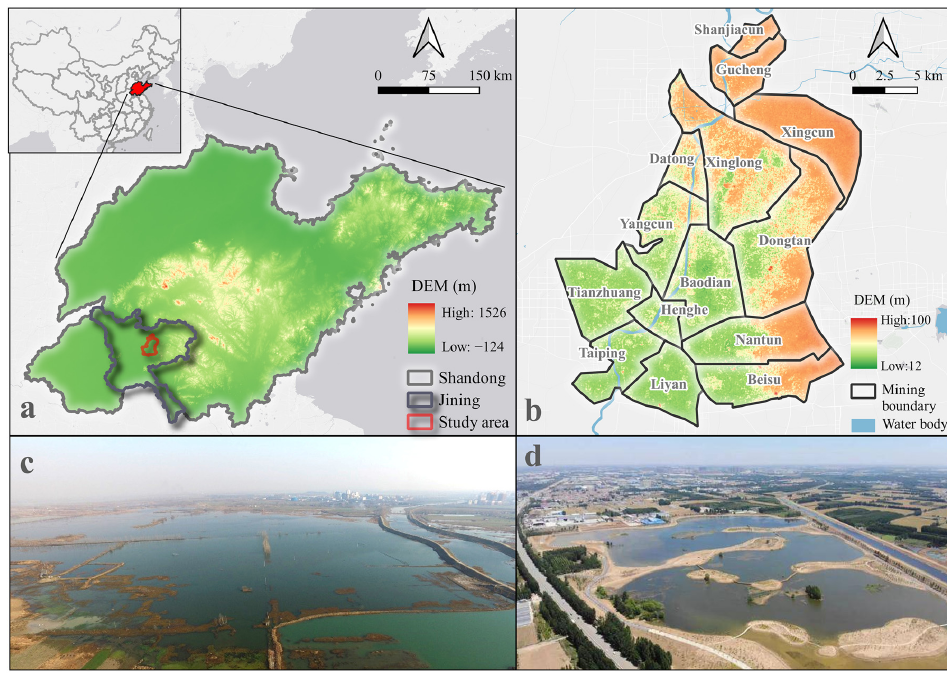
Figure 1. Schematic diagram of the study area: ( a ) location of YZC; ( b ) distribution of coal mines in YZC; ( c ) coal mining has led to water accumulation in large areas of cropland; ( d ) wetland landscape was formed after reclamation.